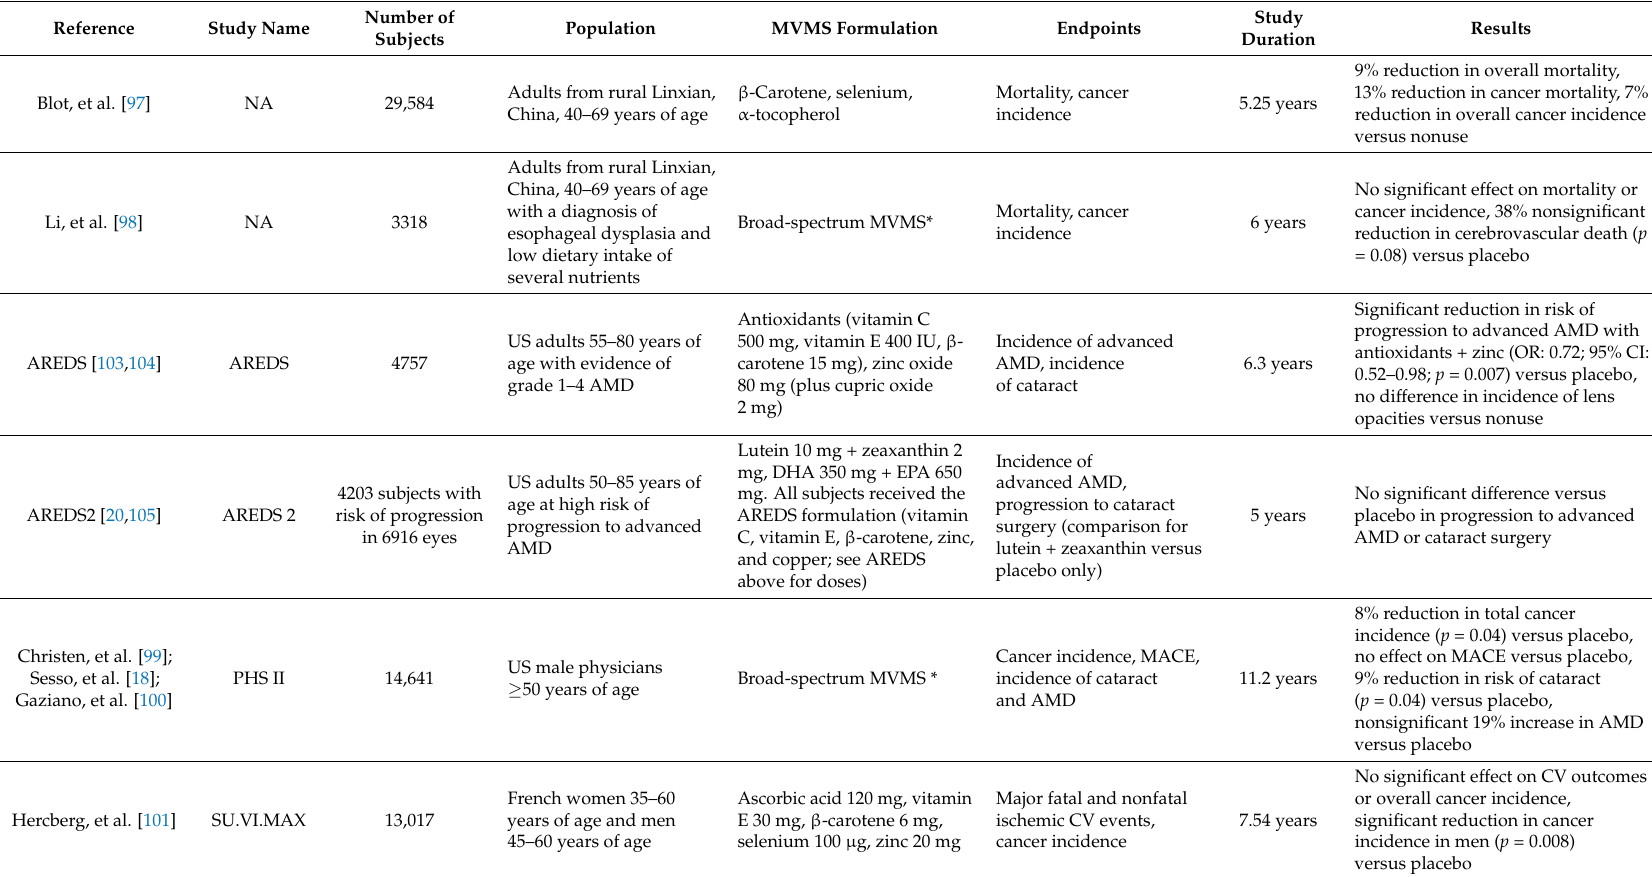
Table 1. Randomized, controlled trials of